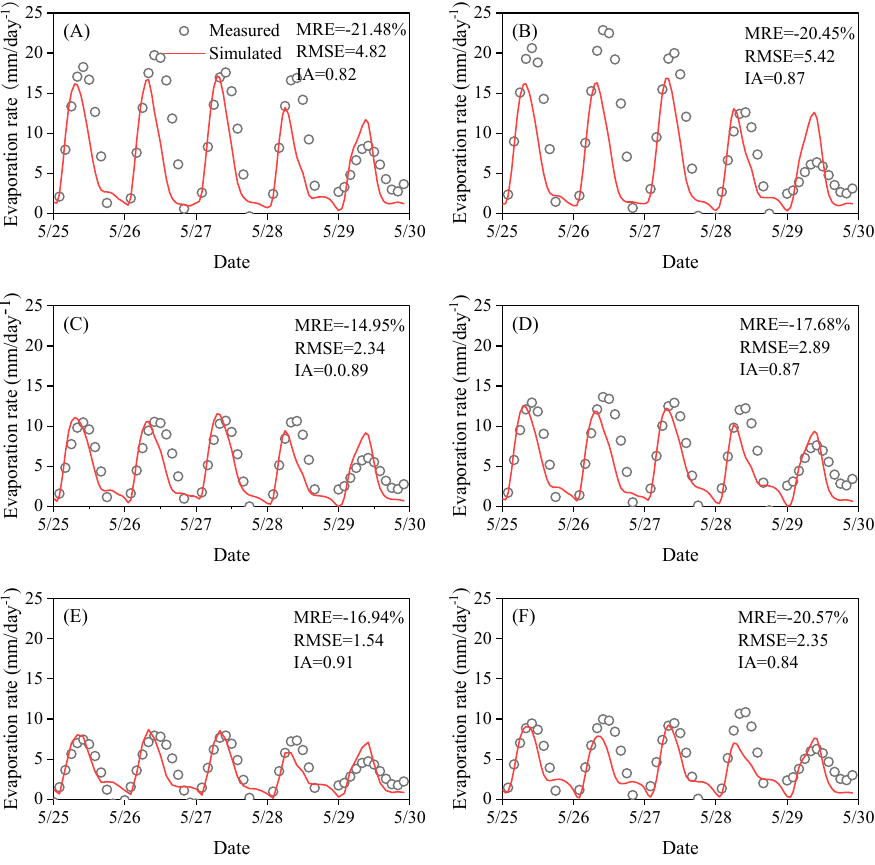
Figure 8. Comparison of simulated and measured evaporation rates for the six treatments: ( A ) T1; ( B ) T2; ( C ) B1; ( D ) B2; ( E ) G1; ( F ) G2. The measured and simulated soil evaporation mass losses (cumulative evaporation rate over time) for the six treatments are depicted in Figure 9. Daily patterns were ladder- type, with a sharp increase during the day and a slight increase at night. Evaporation mass loss was higher for the larger perforation ratio, regardless of film colour. Evaporation mass loss was highest for the transparent plastic films, followed by black and grey-silver plastic films, regardless of perforation ratio. A plot of the simulated vs. measured evaporation mass loss yielded a linear relation- ship for all films (Figure 10). A slope lower than 1 was obtained for the larger perforation ratio (0.9554 for T2 and 0.9113 for G2), indicating that the SMAS model slightly underes- timated the evaporation mass losses for the partially covered soil. Comparison with the MRE, RMSE, and IA values for the evaporation rate revealed that the simulated evapora- tion mass losses are more consistent with the measured data: the MRE of simulated and measured evaporation mass losses decreased sharply (9.13%, − 3.52%, 15.48%, 7.6%, 7.87%, and − 3.91% for T1, T2, B1, B2, G1, and G2, respectively), while the MRE for evaporation rate was − 21.48%, − 20.45%, − 14.95%, − 17.68%, − 16.94%, and − 20.57%, respectively. Fur- thermore, the RMSE of the simulated and measured evaporation mass losses was quite low (0.57, 1.16, 1.15, 0.40, 0.48, and 1.04 for T1, T2, B1, B2, G1, and G2, respectively), whereas the IA increased to 0.9988, 0.9949, 0.9901, 0.9991, 0.9971, and 0.9904, respectively. Thus, the large error between the simulated and measured evaporation rates decreased when